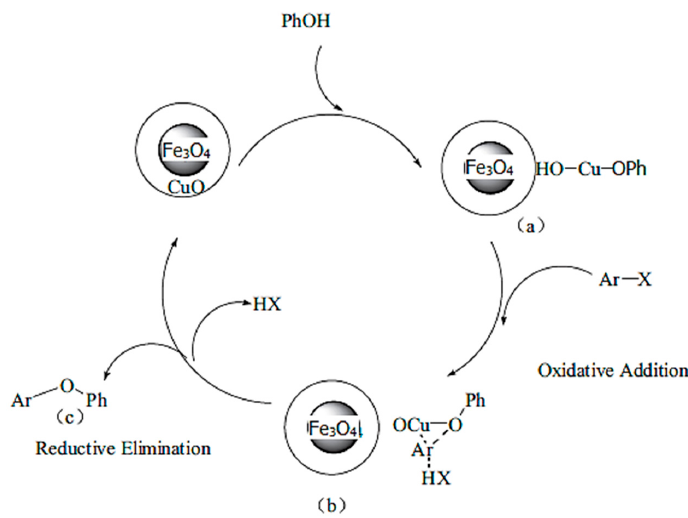
Scheme 13. The mechanism of CuO-Fe 3 O 4 -catalyzed C-O bond formation reaction; ( a ) oxidative addition, ( b ) intermediate ( c ) reductive elimination.